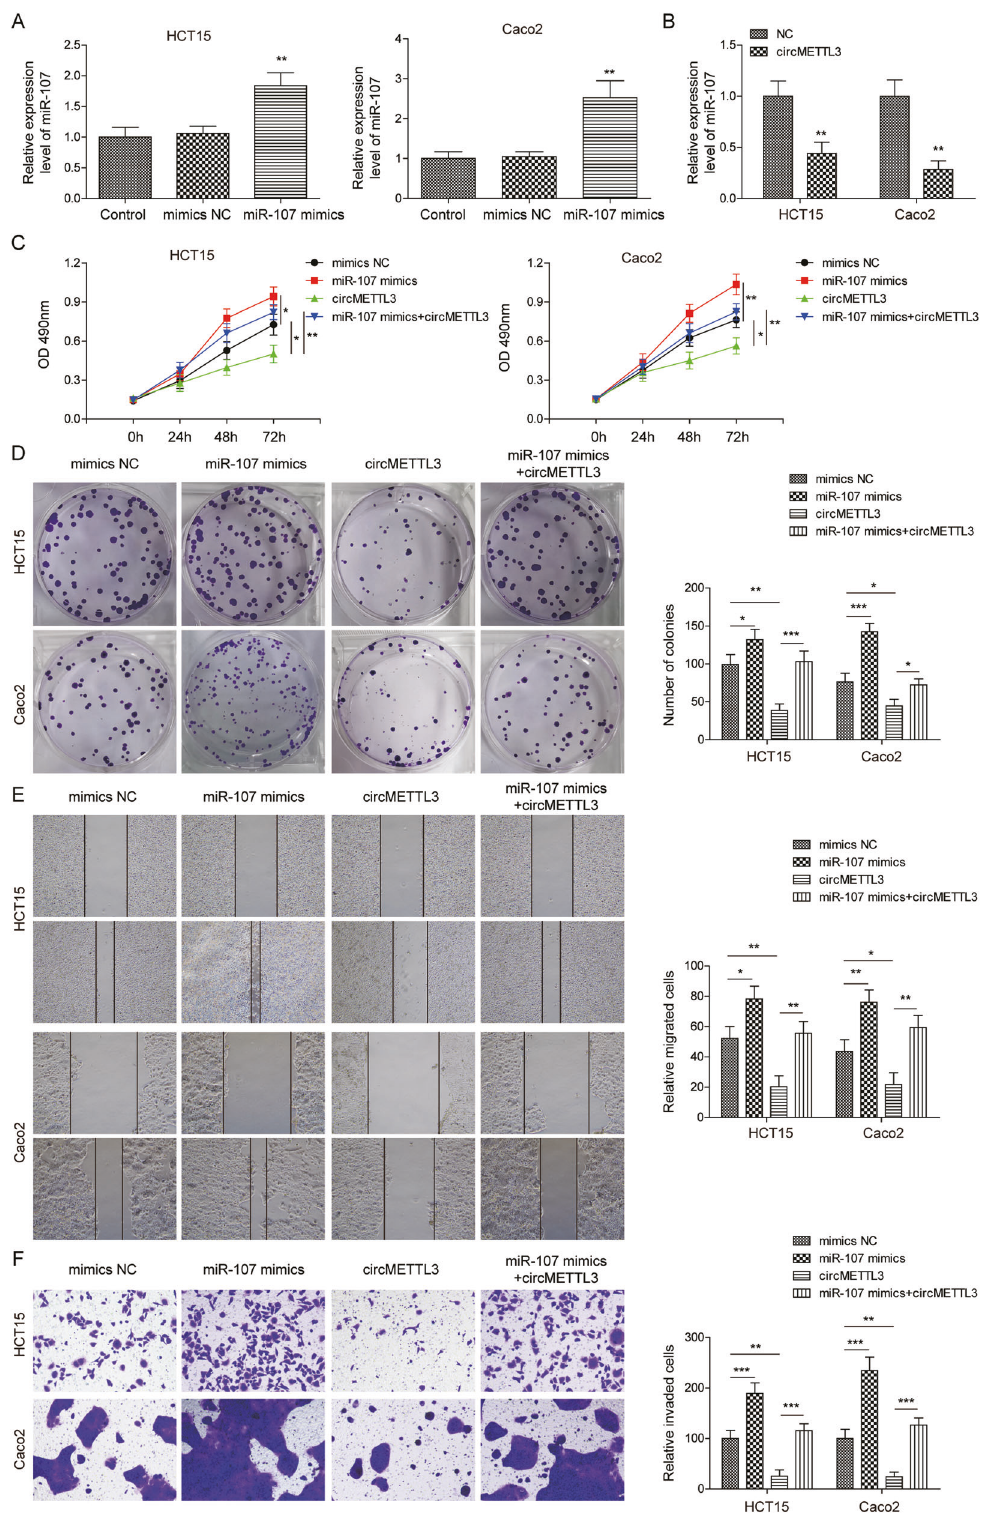
Fig. 5 circMETTL3 regulated CRC cell proliferation and migration via miR-107 in vitro. A Relative miR-107 levels in transfected Caco2 and HCT15 cells. B Relative miR-107 levels in circMETTL3 overexpression Caco2 and HCT15 cells. C CCK-8 assay to measure cell viability. D Colony formation assay to assess cell proliferation. E Scratch wound assay to analyze cell migration ability. F Transwell assay to evaluate cell invasion ability.